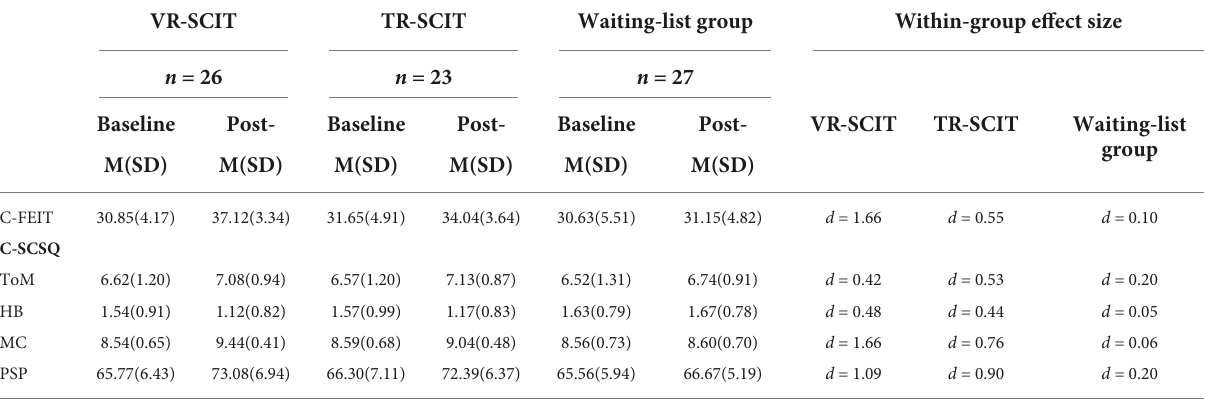
TABLE 3 Social cognition and social functioning outcomes among groups. VR-SCIT TR-SCIT Waiting-list group Within-group effect size n = 27 Baseline Post- Baseline Post- Baseline Post- VR-SCIT TR-SCIT Waiting-list